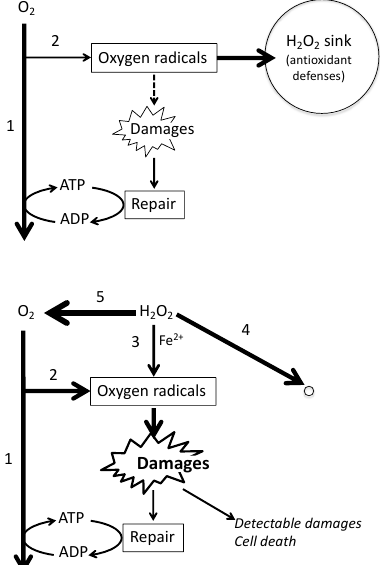
Figure 9. Scenario for H 2 O 2 mediated oxidative damage. Top: normal cellular physiology, endogenous oxygen metabolism is essentially devoted to mitochondrial ATP generation (1). This and other oxygen using enzymes generate oxygen radicals (2) and a vast majority is eliminated by antioxidant defenses. Some oxidative damages (Damages) occur and cellular bioenergetics contributes to their reparation resulting in a steady state with no accumulation of oxidative lesions.